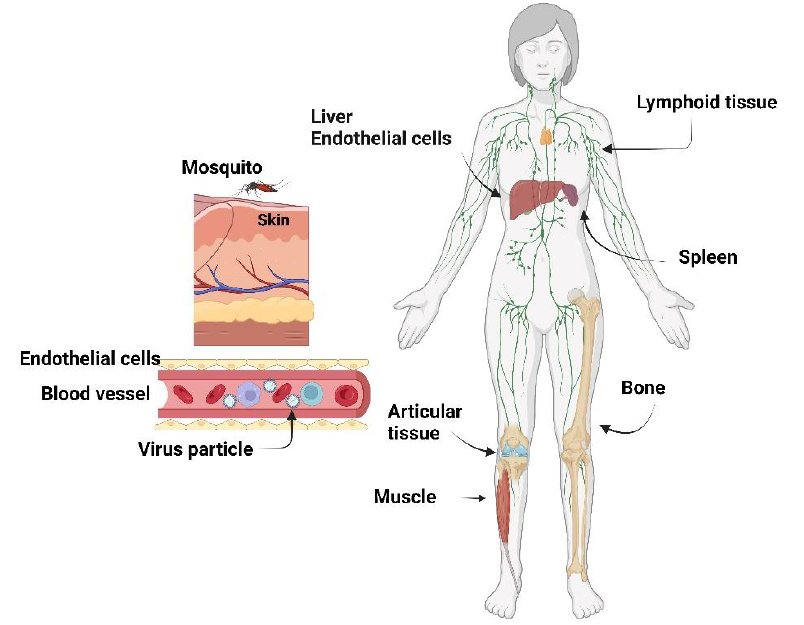
Figure 3. Alphavirus dissemination. Probable alphavirus dissemination in humans after inocula- tion of the virus through the mosquito vector bite. It propagates into the target tissues (muscle, articular tissue, liver, spleen, etc.) via the blood vessels. Created with BioRender.com (Accessed on 10 September 2022).